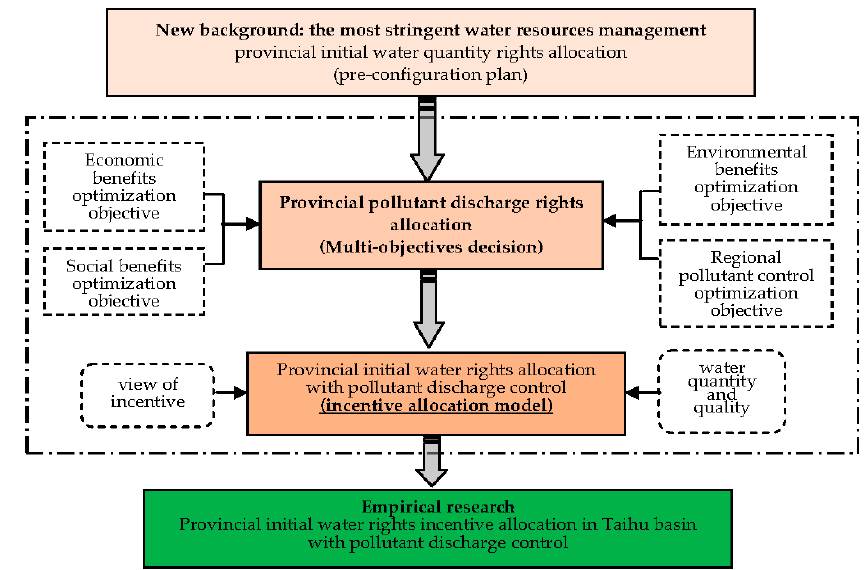
Figure 1. Framework of provincial initial water right incentive allocation.